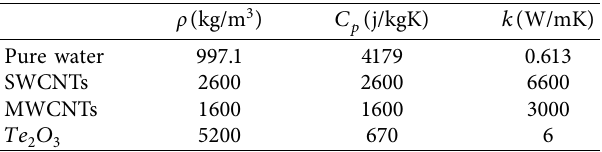
Table 1: Thermo-physical properties of water, CNT s , and Te nanoparticles.